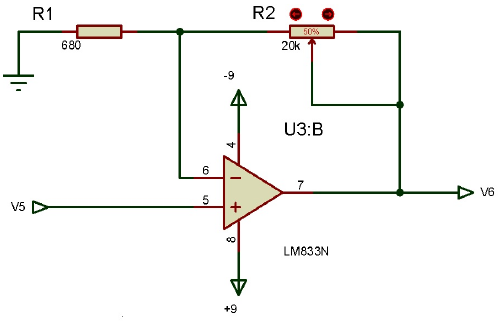
Figure 7. Non-inverting amplifier schematic.